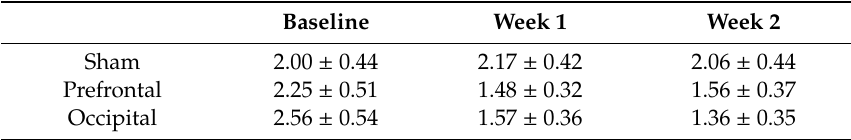
Table 6. Summary statistics of the number of consumed pills per day in the three brain stimulation conditions at baseline, week 1, and week 2. Data are represented as mean ± standard